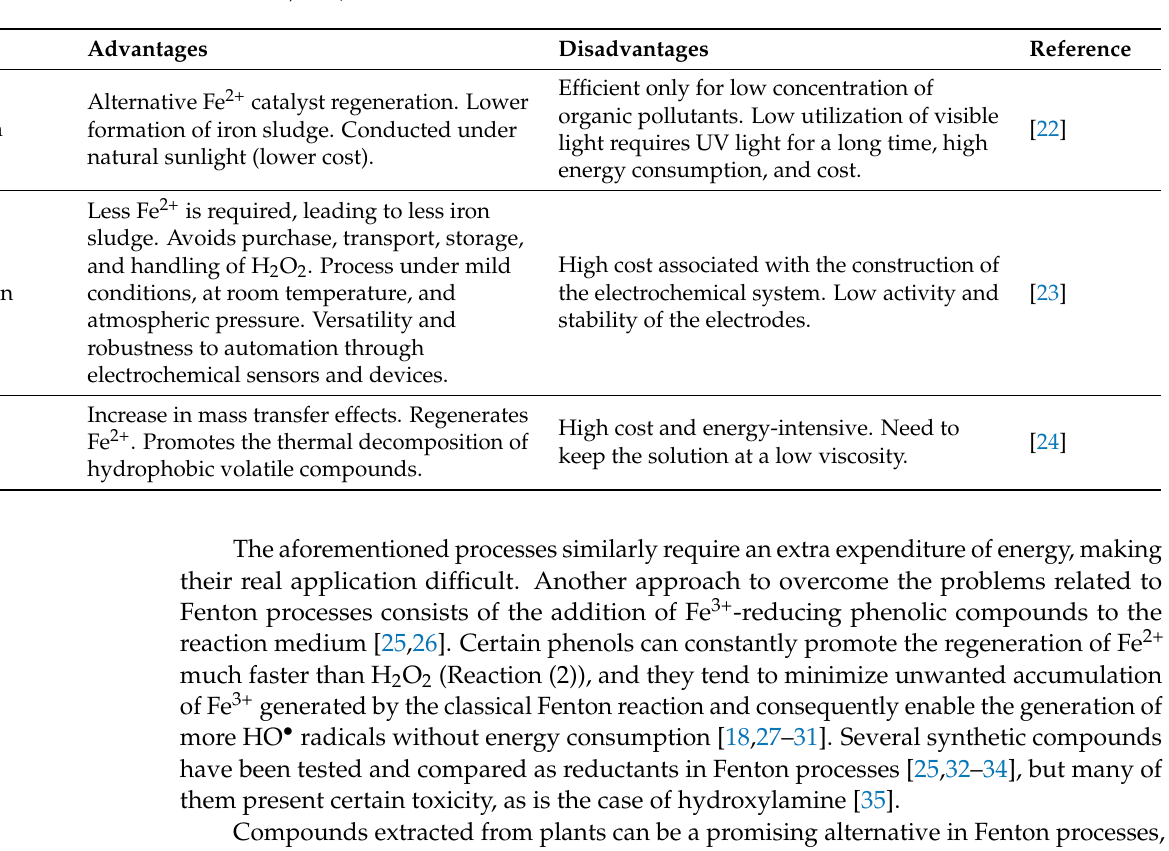
Table 1. Advantages and disadvantages of Fenton processes improvised by UV/visible irradiation, ultrasound, and/or electrical current.